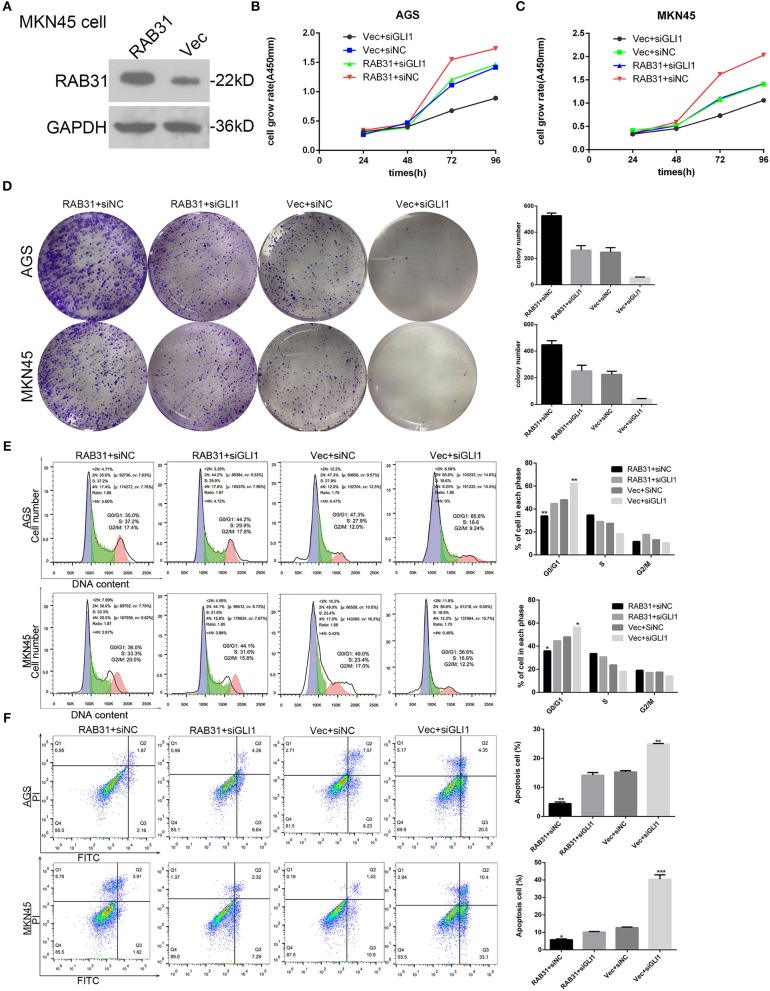
RAB31 promotes GC progression through activation of the GLI1 pathway in vivo. (A) Western blotting was performed to evaluate the overexpression of RAB31 after transfection of plasmids into MKN45 cells. (B–F) AGS and MKN45 cells with enhanced RAB31 expression and vector control were transfected simultaneously with GLI1 siRNA and siNC, respectively. (B,C) The viability of AGS and MKN45 cells was determined by the CCK8 assay. (D) Representative images of colony formation assays are shown on the left; the average colony formation from three experiments is shown by the histogram on the right (P < 0.01). (E,F) Cell cycle and apoptosis were assessed by flow cytometry. Representative images are on the left and the results of triplicate assays are shown on the right. Results are shown as the mean ± SD (*P < 0.05, **P < 0.01, and ***P < 0.001).